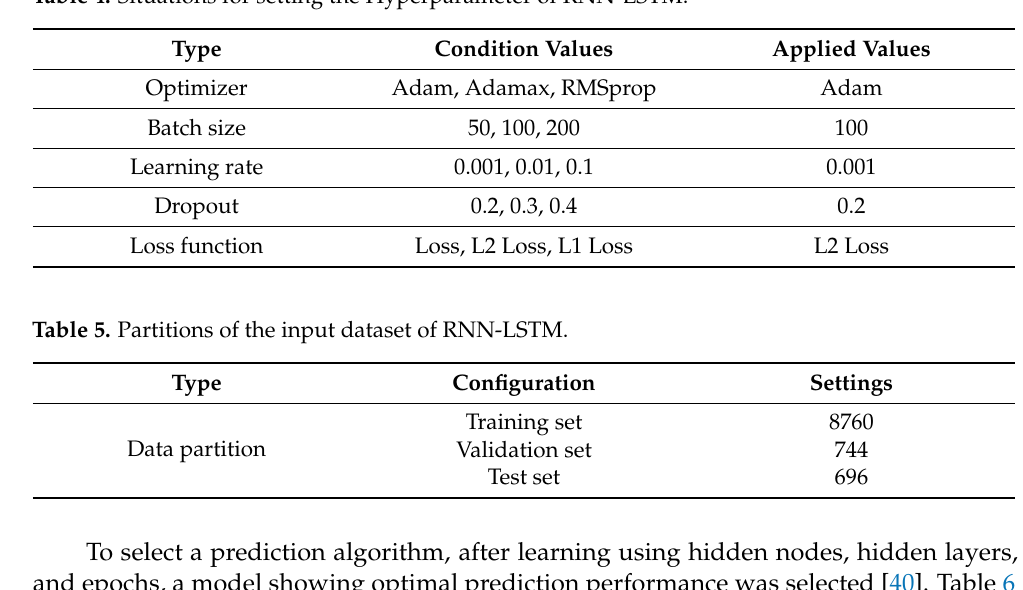
Table 4. Situations for setting the Hyperparameter of RNN-LSTM.